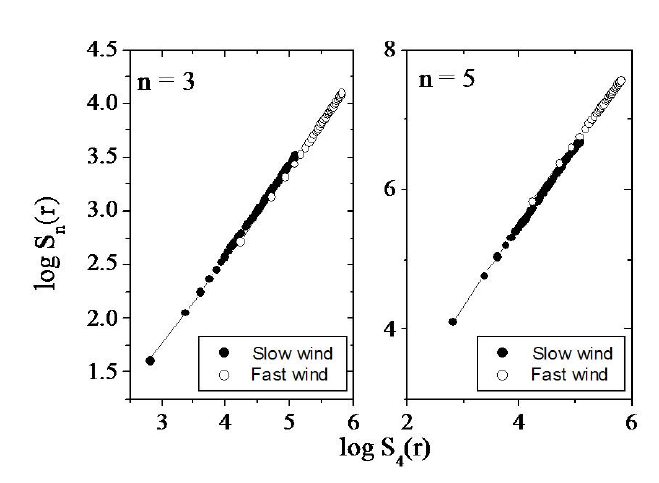
Figure 81: Structure functions 𝑆 𝑛 ( 𝑟 ) for two different orders, 𝑛 = 3 and 𝑛 = 5, for both slow wind and high wind, as a function of the fourth-order structure function 𝑆 4 ( 𝑟 ). Data come from Helios 2 spacecraft at 0.9